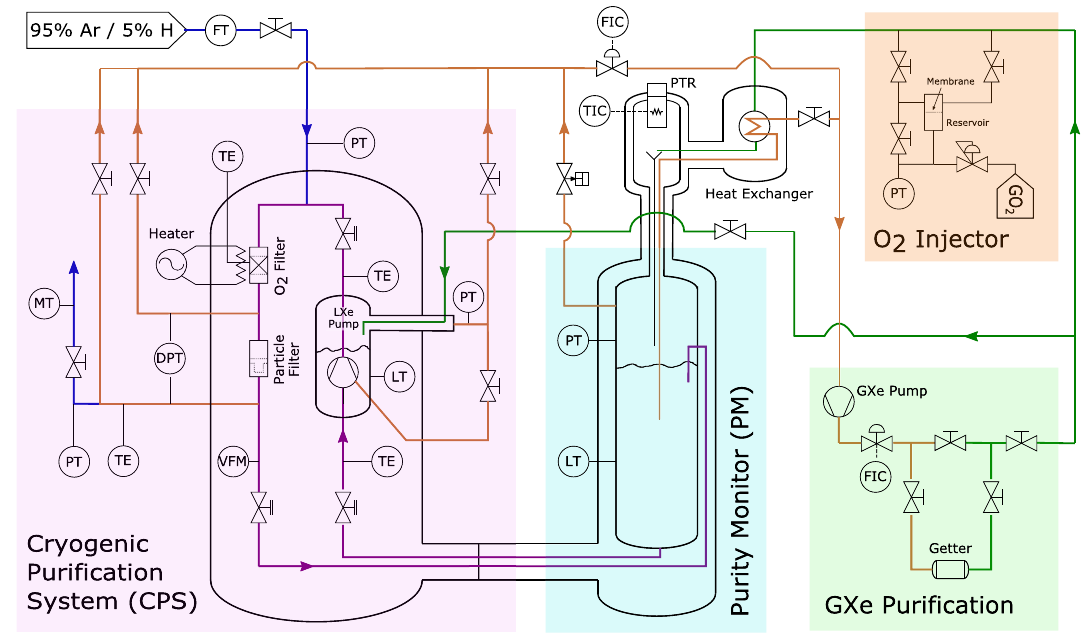
Fig. 2 Simplified process and instrumentation diagram (P&ID) of Xeclipse, with the constituent subsystems delineated by boxes. Two independent vacuum-insulated stainless steel cryostats house the Cryo- genic Purification System (CPS) and the Purity Monitor (PM). Also shown are the exterior gas handling systems, including the GXe Purifi- cationloopusingtraditionalheatedgetterpurification, andtheO 2 injec- tor used to control the rate at which impurities are introduced into the PM. The xenon flow lines are grouped by color to illustrate the typical configuration. Orange-brown lines carry GXe to the getter, and green